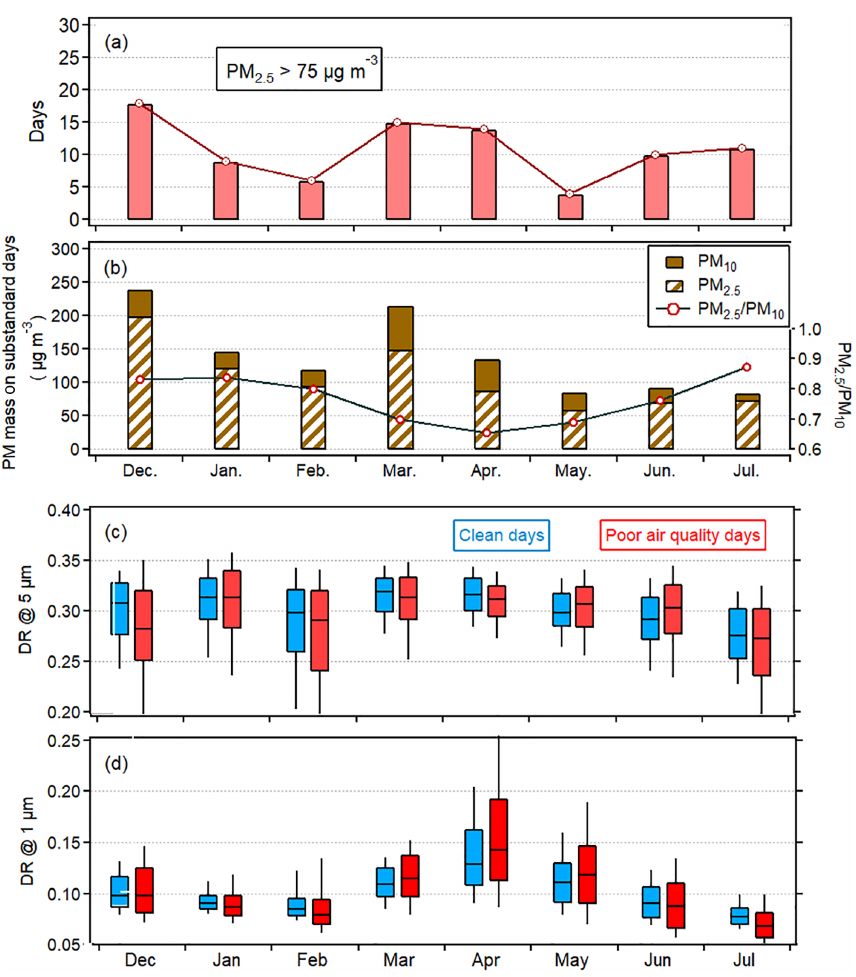
Figure 5. (a) The number of poor air quality days, (b) daily averaged mass concentration of PM 2 . 5 and PM 10 on the poor air quality days and the ratio of PM 2 . 5 / PM 10 , (c) a box plot of particle δ values of Dp = 5 and (d) Dp = 1µm on clean days (PM 2 . 5 <35µgm − 3 ) and poor air quality